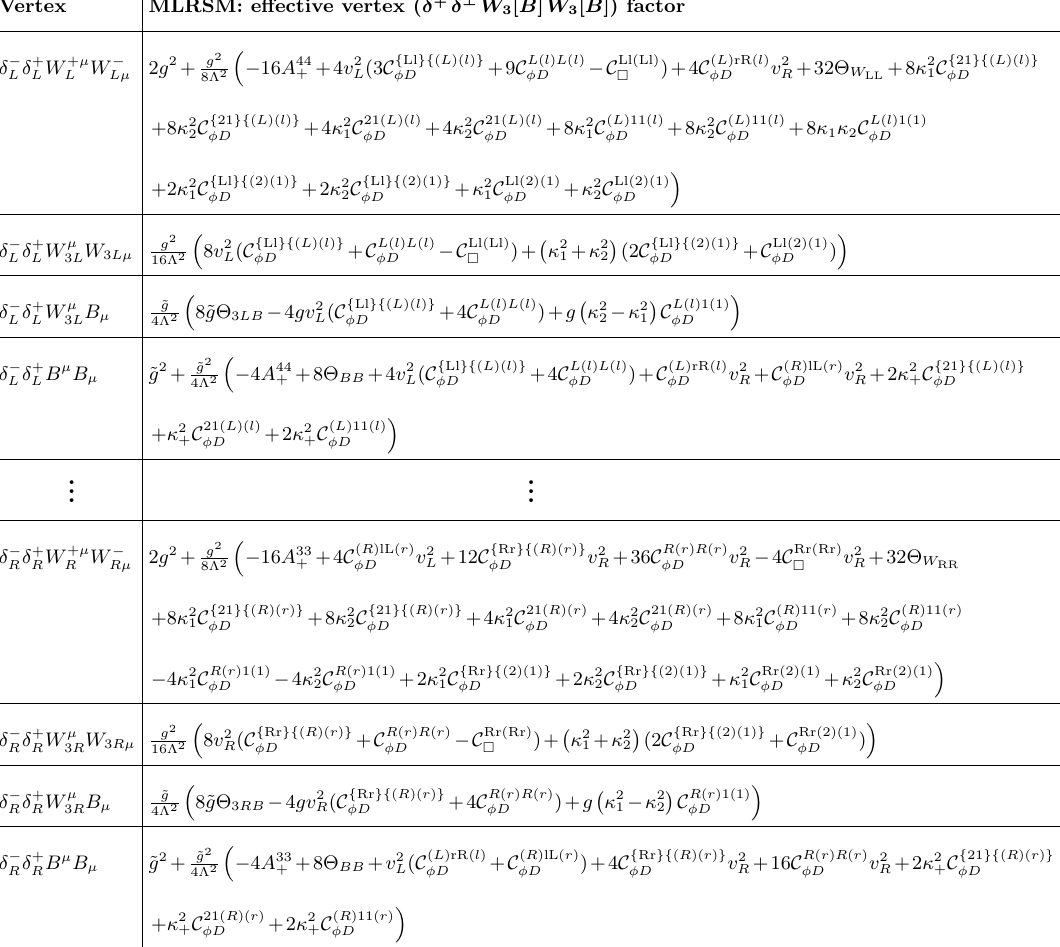
Table 46. MLRSM: coupling of a pair of singly charged scalars ( (cid:14) (cid:6) ) with either a pair of charged ( W (cid:6) ) or neutral ( B; W 3 L; 3 R ) gauge bosons in unphysical basis. These can be translated in physical L;R gauge boson basis using rotation matrix e R a;b